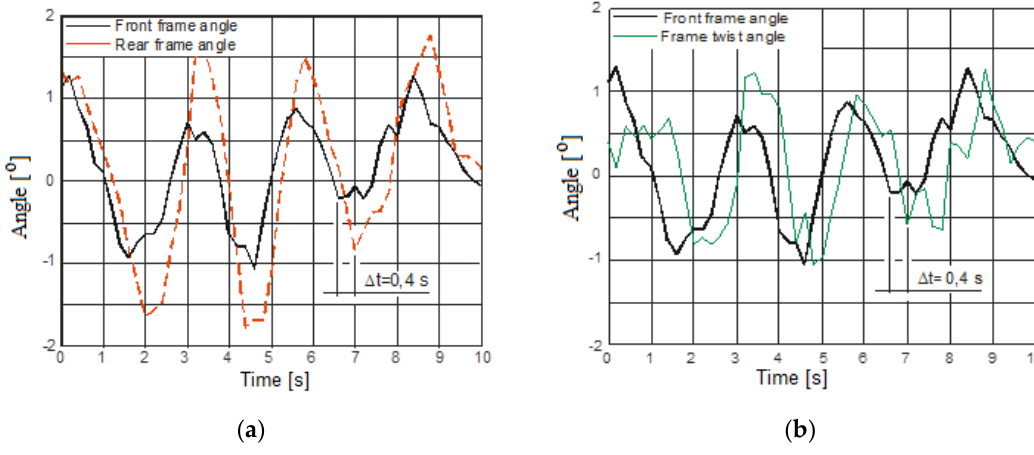
Figure 4. Angular frame deviation during straight-line drive ( a ) and frame turn and angular deviation of front frame ( b ).